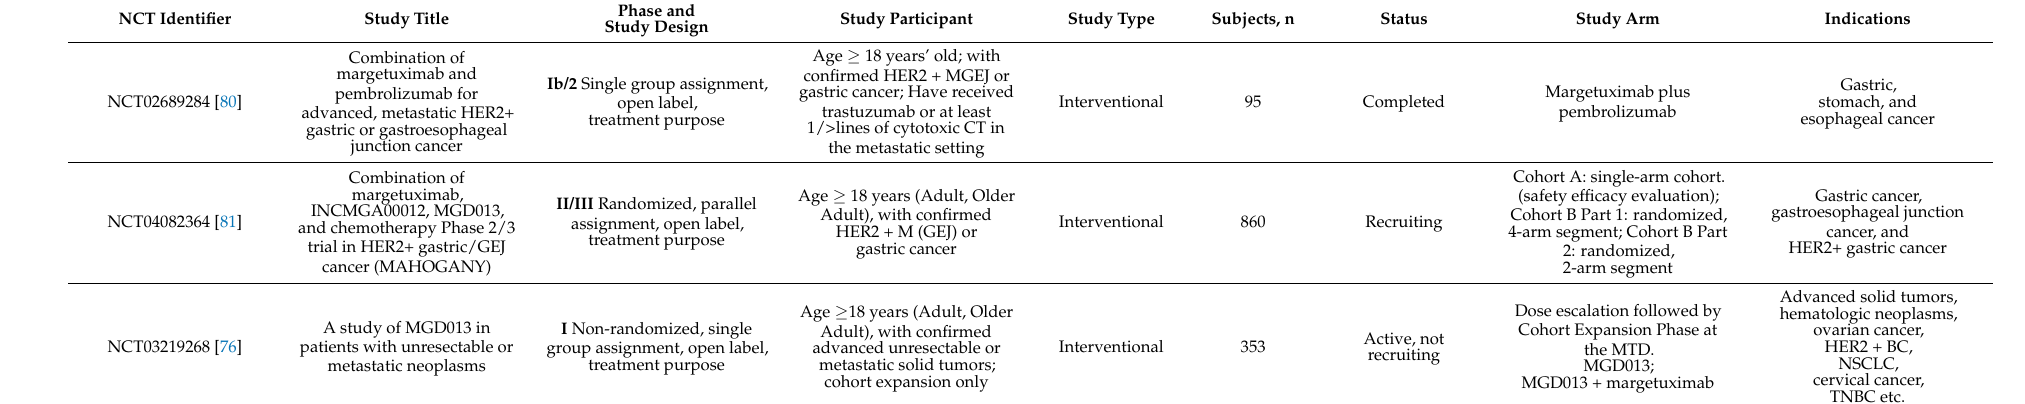
Table 3. Clinical trials involving margetuximab in other types of cancer